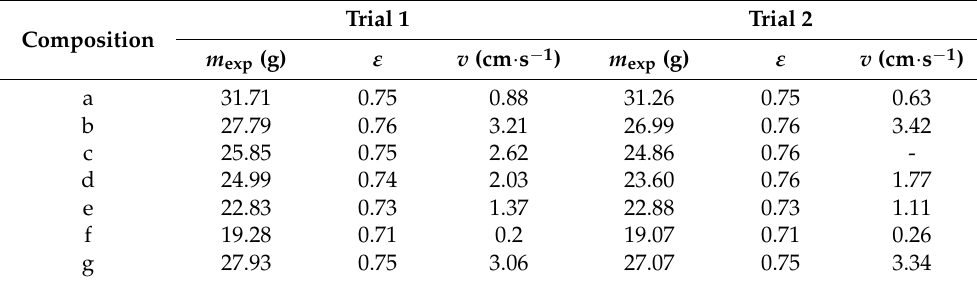
Table 3. Measured binary compositions burning velocities with associated experimental masses and porosities.